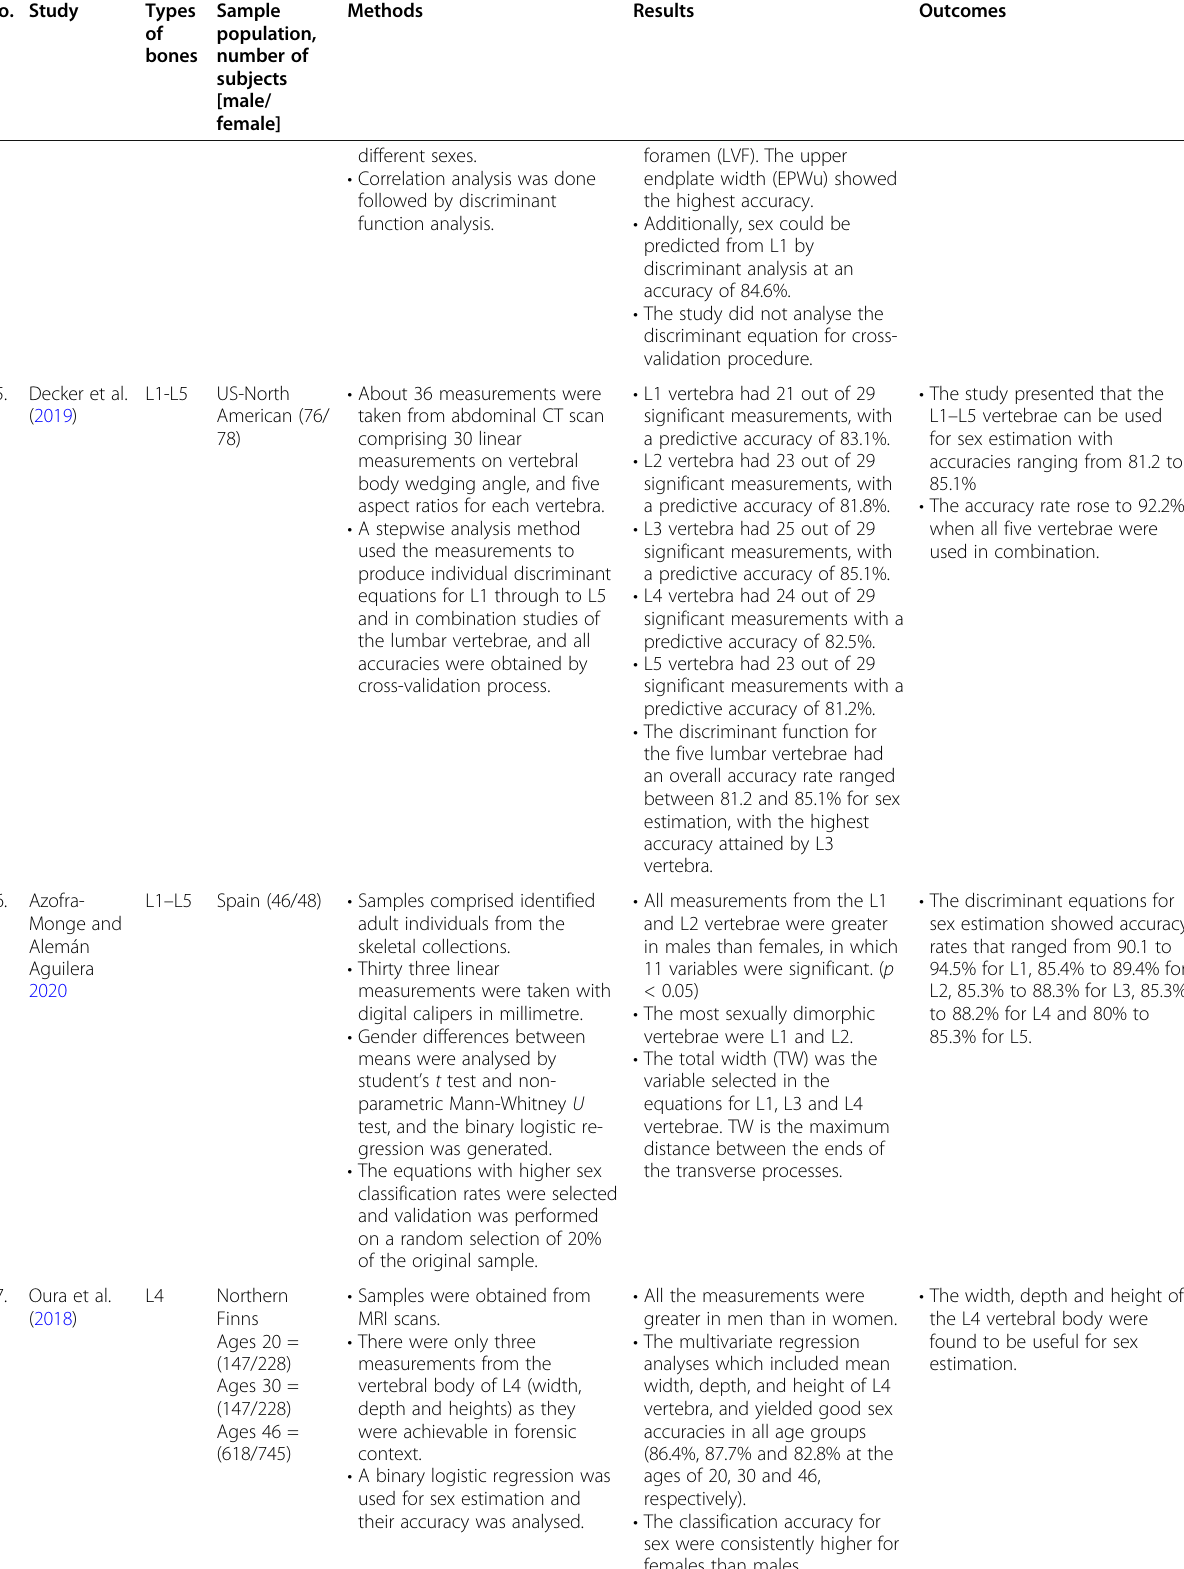
Table 1 The descriptive studies on sexual dimorphism in vertebral bone (Continued) No.